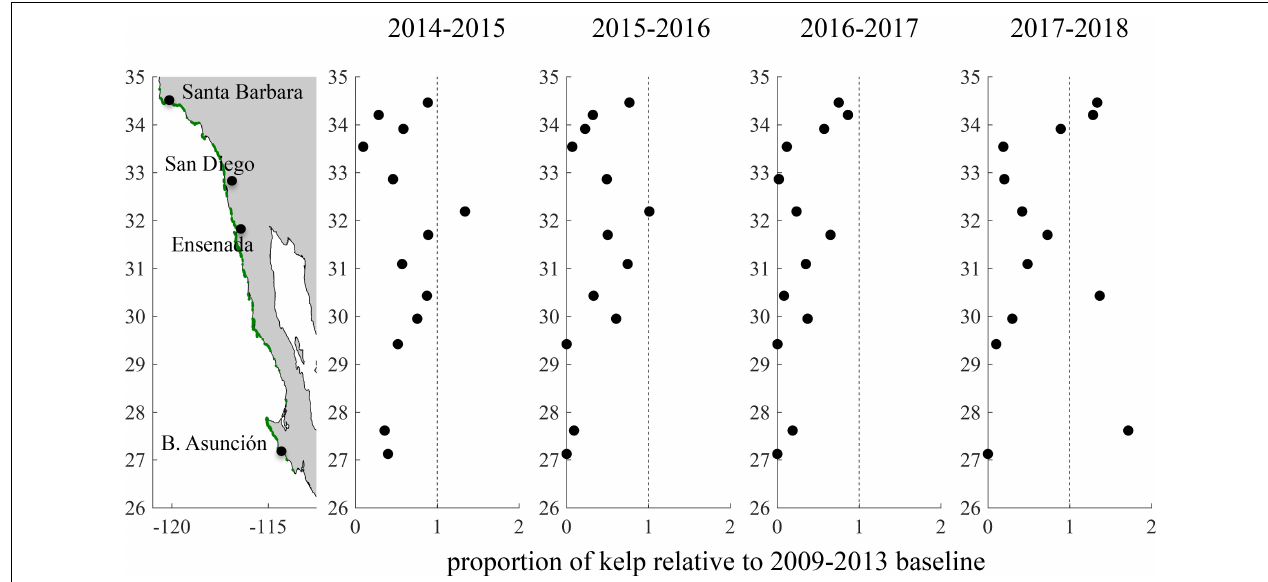
FIGURE 6 | Change in kelp canopy biomass in southern and Baja California during and after the 2014–2016 warm period. For each year, mean giant kelp canopy biomass from July to June was divided by the mean canopy biomass between 2009 and